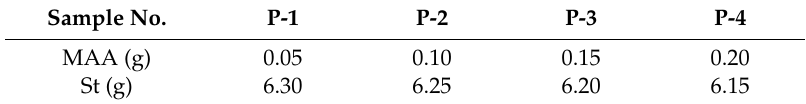
Table 1. E ff ect of monomer ratio on the performance of P(MAA / St) microspheres. Sample